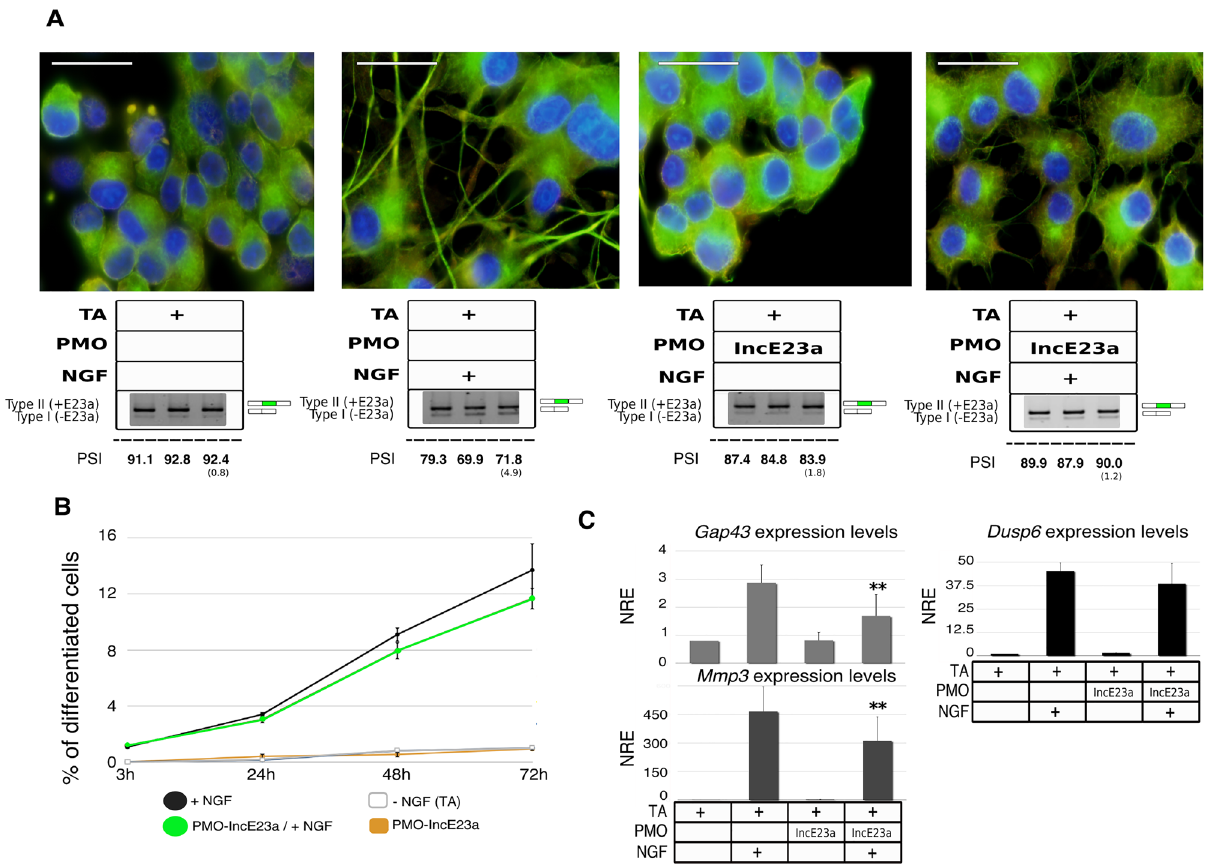
Figure 5. Impact of forcing E23a inclusion using PMO-IncE23a on NGF-induced PC12 neuronal differentiation. ( A ) Top: Representative images of a double immunofluorescent staining of NGFR (red) and α-tubulin (green) of PC12 cells after 72 h at different experimental conditions (scale bar = 30 μm). Bottom: Box specifying the different experimental conditions and the type II/I isoform expression ratio measured by RT-PCR. E23a splicing was quantified as the percent spliced-in (PSI) (standard deviation in parentheses). Supporting whole gel images can be found in Supplementary Fig. S5A. ( B ) Time course analysis of the percentage of differentiated cells per field for each experimental condition. Each point represents the Mean ± SEM. Complementary neurite thickness analysis can be found in Supplementary Fig. S5B. ( C ) Expression of the neuronal differentiation markers Dusp6 , Gap43 and Mmp3 at the different experimental conditions set, analyzed by RT-qPCR. NRE: Normalized Relative Expression ( Rpl29 and Rpl19 were used as reference genes). Bars indicate Mean ± SEM. ** P < 0.01, paired t -test against cells treated only with NGF. TA: transfection